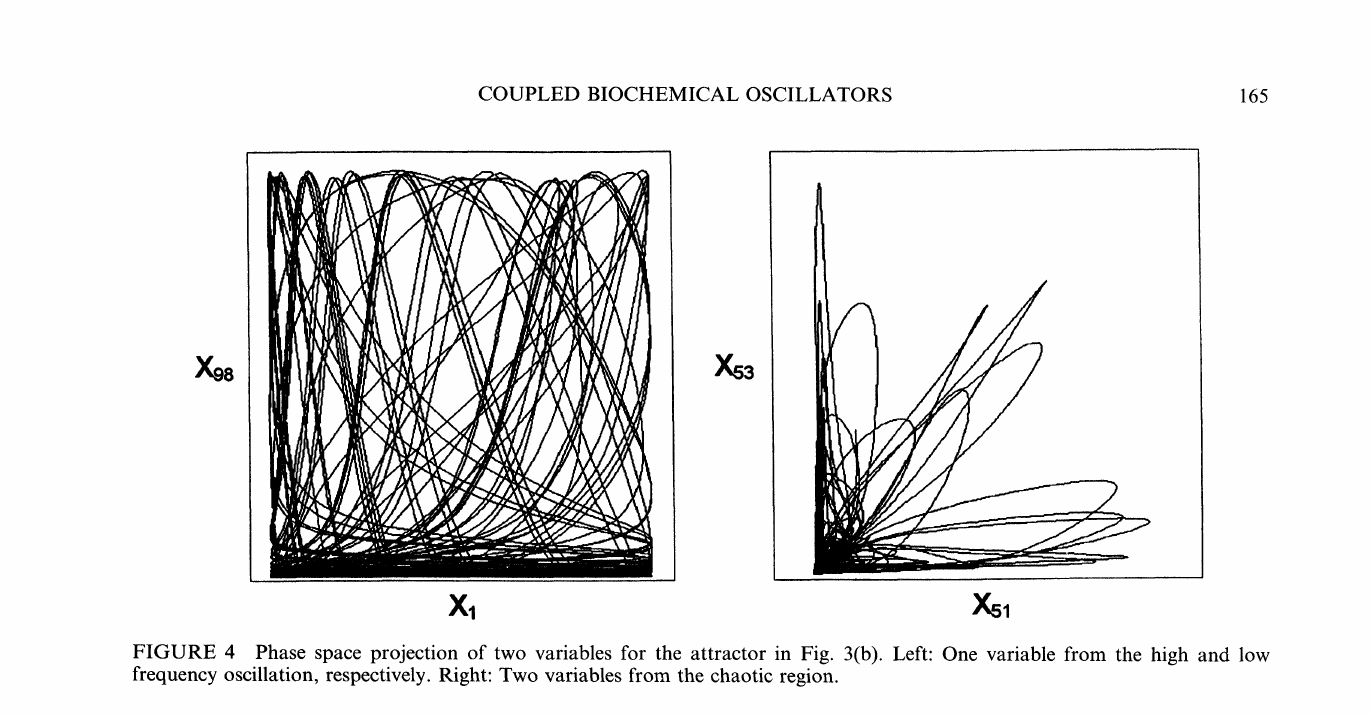
FIGURE 4 Phase space projection of two variables for the attractor in Fig. 3(b). Left: One variable from the high and low frequency oscillation, respectively. Right: Two variables from the chaotic